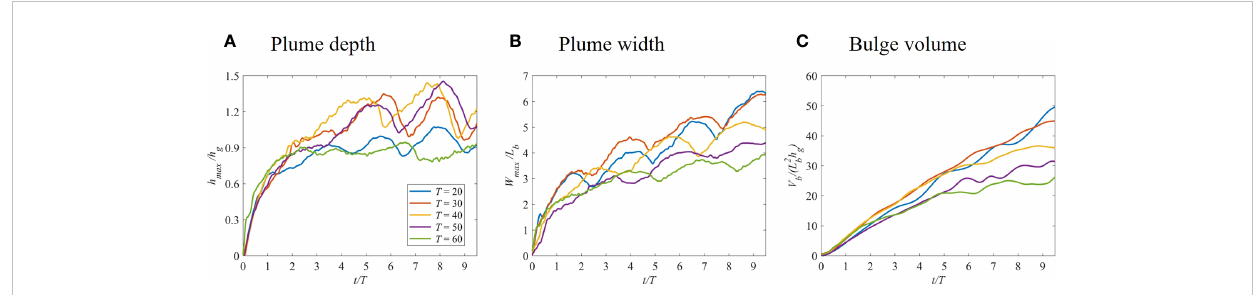
FIGURE 7 Time series of plume featured parameters normalized maximum plume depth (A) , maximum plume width (B) and bulge volume (C) for different rotation rates in runs 36 – 40 ( a = 0.1, g ’ = 7